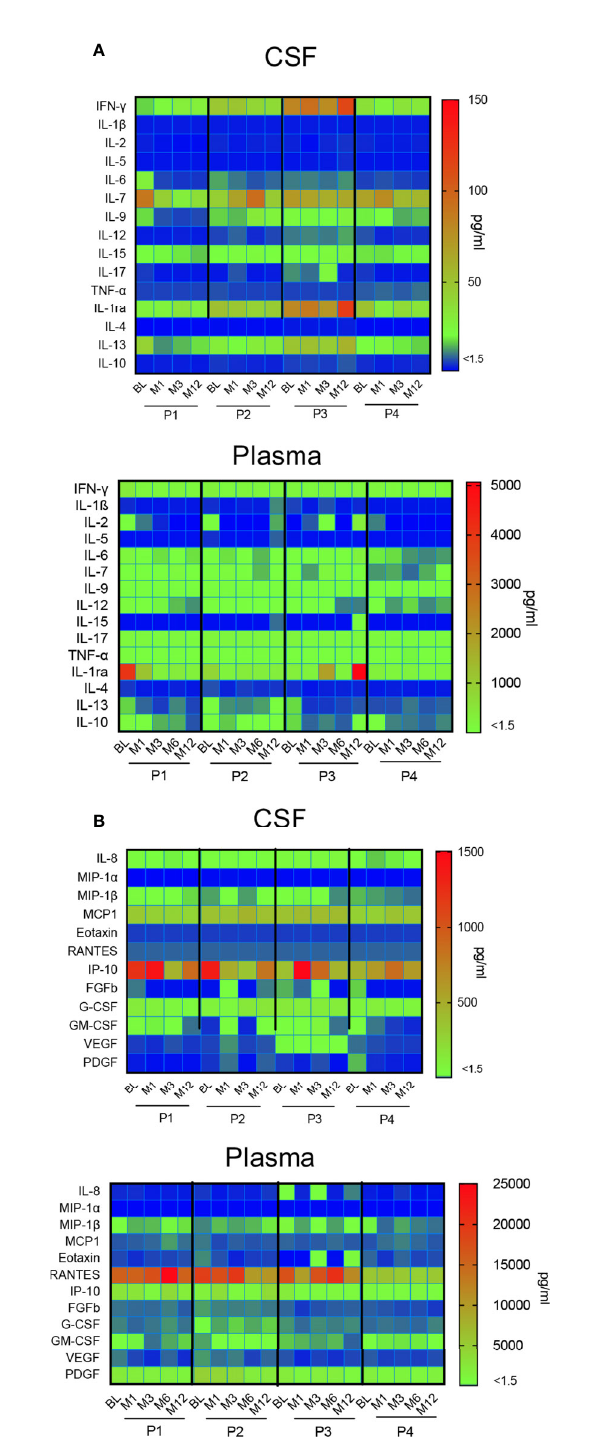
FIGURE 7 | Impact of gene therapy on neuroin fl ammation. Heat map representing the broad array of cytokines (A) and chemokines (B) assessed by multianalyte pro fi ling of 27 metabolites in patients ’ CSF and plasma, at indicated time-points. The colored scale bar shows the range of concentrations expressed in